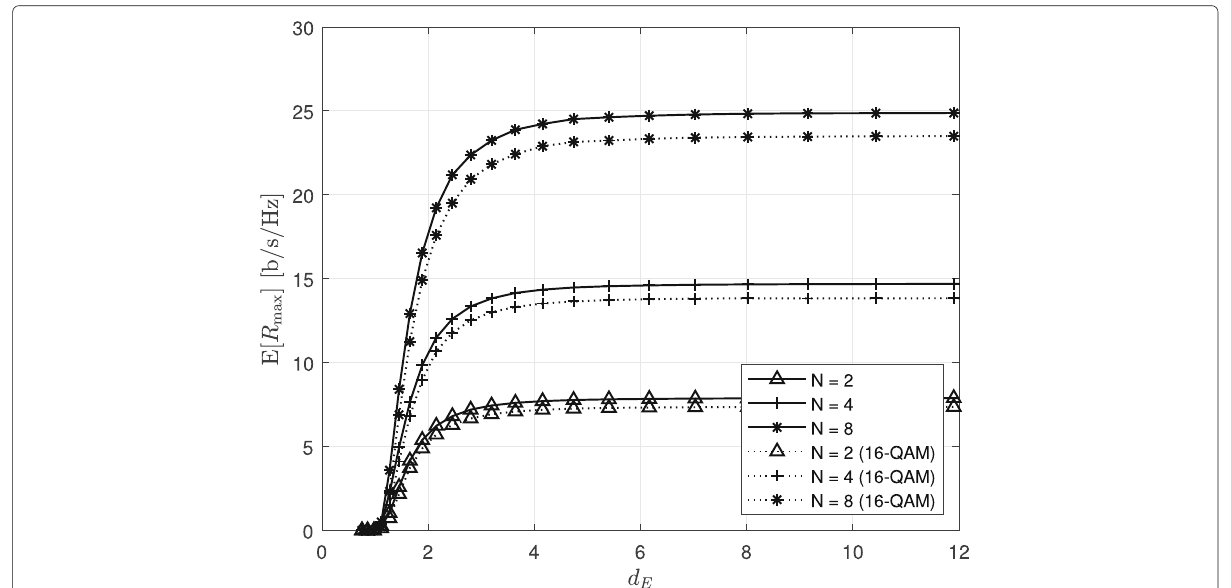
Fig. 9 Average maximum outage secrecy rate as a function of d E with finite-length coding ( m = 4096), both Gaussian and discrete (16-QAM) constellations, and various values of